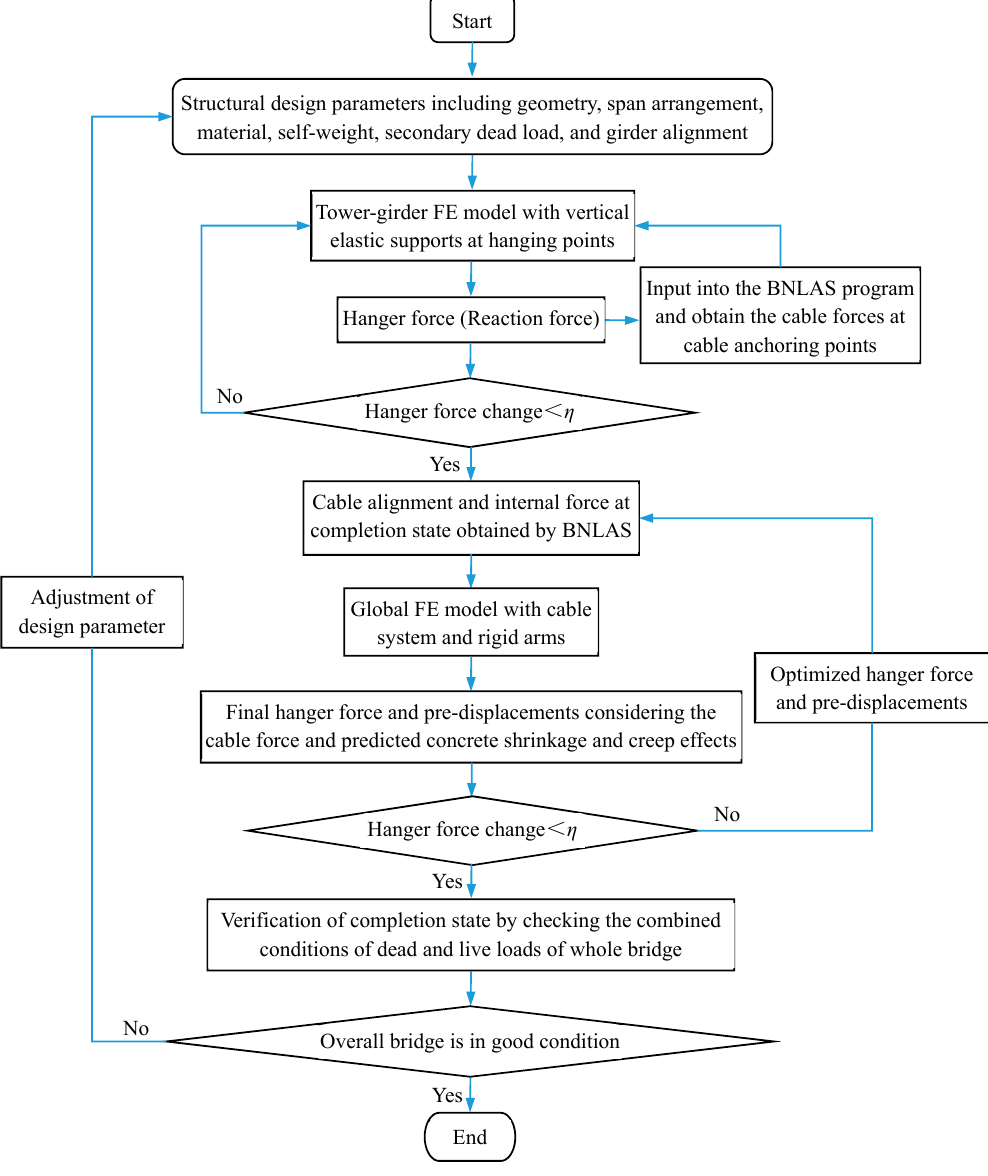
Figure 10. Algorithm flowchart of reasonable completion state determination for concrete self-anchored suspension bridge.